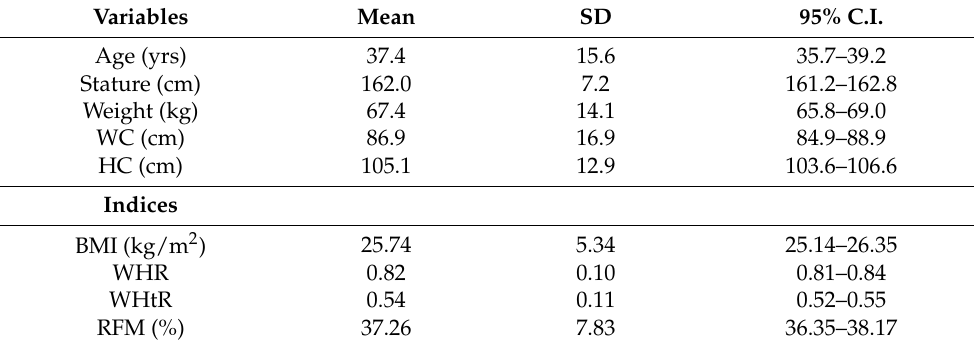
Table 3. Anthropometric characteristics of the Moroccan sample ( n =